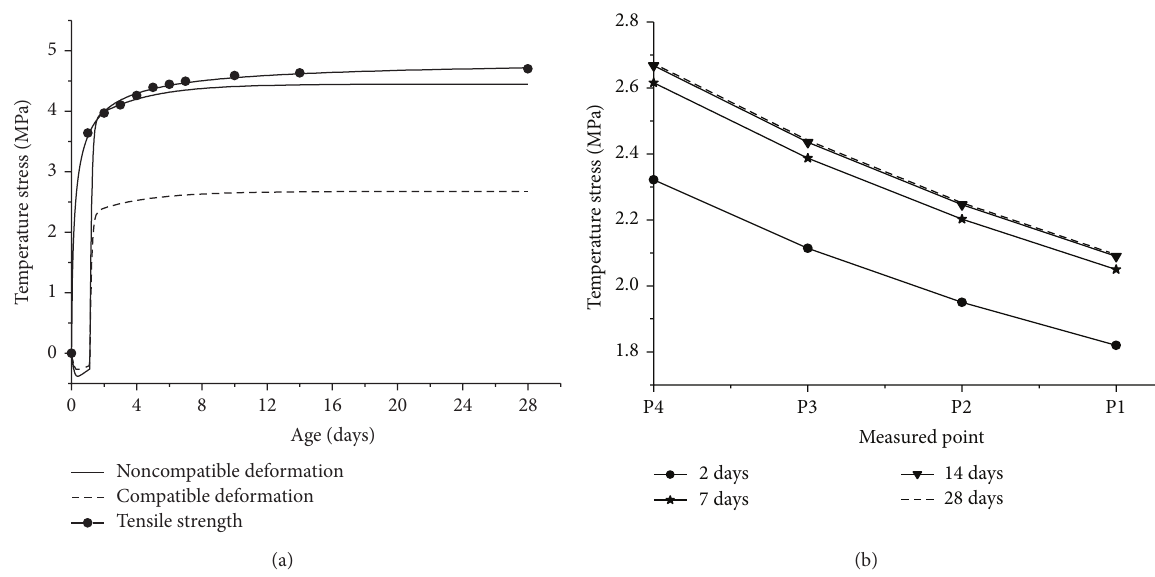
Figure 8: Thermal residual stress development with age. (a) Thermal residual stress at Point 4; (b) thermal residual stress distribution with